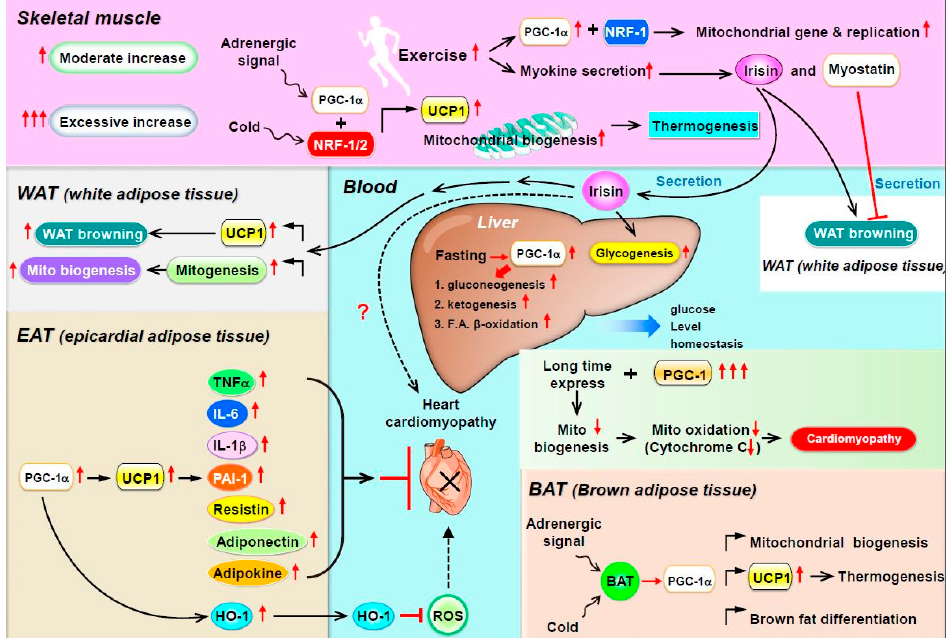
Figure 1. Schematic description of peroxisome proliferator-activated receptor gamma coactivator-1 α (PGC-1 α ) function in various organs. Traditionally, in brown adipocytes (BAT) and white adipocytes (WAT), mitochondrial biogenesis and BAT gene expression are regulated by PGC-1 α . Adrenergic stimulation and lower temperature trigger signaling cascades, including the upregulation of UCP-1 level, thereby resulting in body thermogenesis. In skeletal muscle and WAT, the transcriptional activity of PGC-1 α is responsible for the expression of gene networks that control glucose uptake, glycolysis, fatty acid (FA) oxidation, tricarboxylic acid cycle, oxidative phosphorylation (OXPHOS),